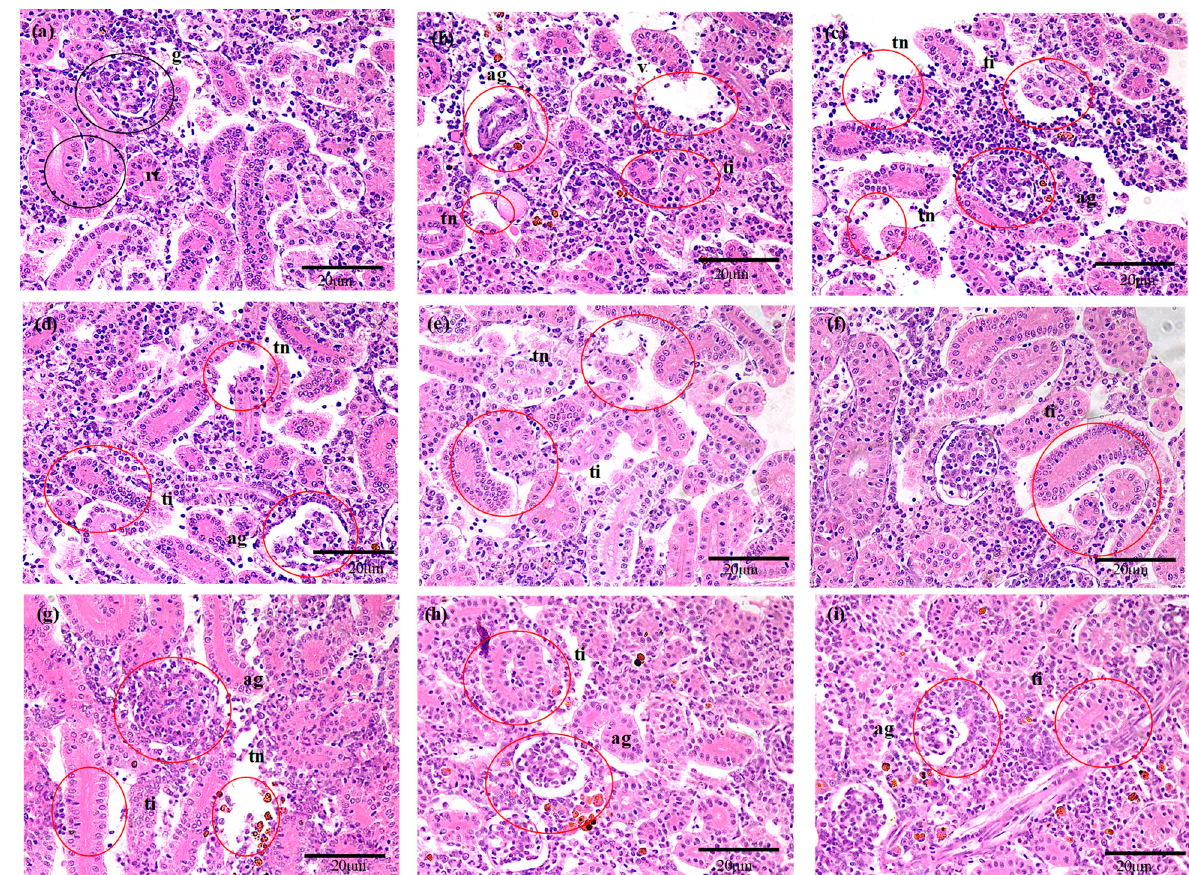
Figure 5. Comparative histological images of kidney of the common carp C. carpio from the different experimental exposures. ( a ) Regular kidney morphology of carps from the control negative group; ( b ) Kidney of carps from the control positive group exposed to 1.5 mg/L of CuO; ( c ) Kidney of carps from the control positive group exposed to 1.5 mg/L of Cu-NPs; ( d – f ) Kidney of carps exposed to 1.5 mg/L of CuO in addition to MSFE administrated at 4 mg/L ( d ), 8 mg/L ( e ) and 12 mg/L ( f ); ( g – i ) Kidney of carps exposed to 1.5 mg/L of Cu-NPs in addition to MSFE administrated at 4 mg/L (g), 8 mg/L ( h ) and 12 mg/L ( i ). Overall, it is possible to notice normal glomerulus ( g ), normal renal tubule (rt), abnormal glomerulus (ag), tubular injury (ti), and tubular necrosis (tn). The scale bar represents 20 µm; five fields of one histological section per sample were analyzed (H&E; 20× magnification).